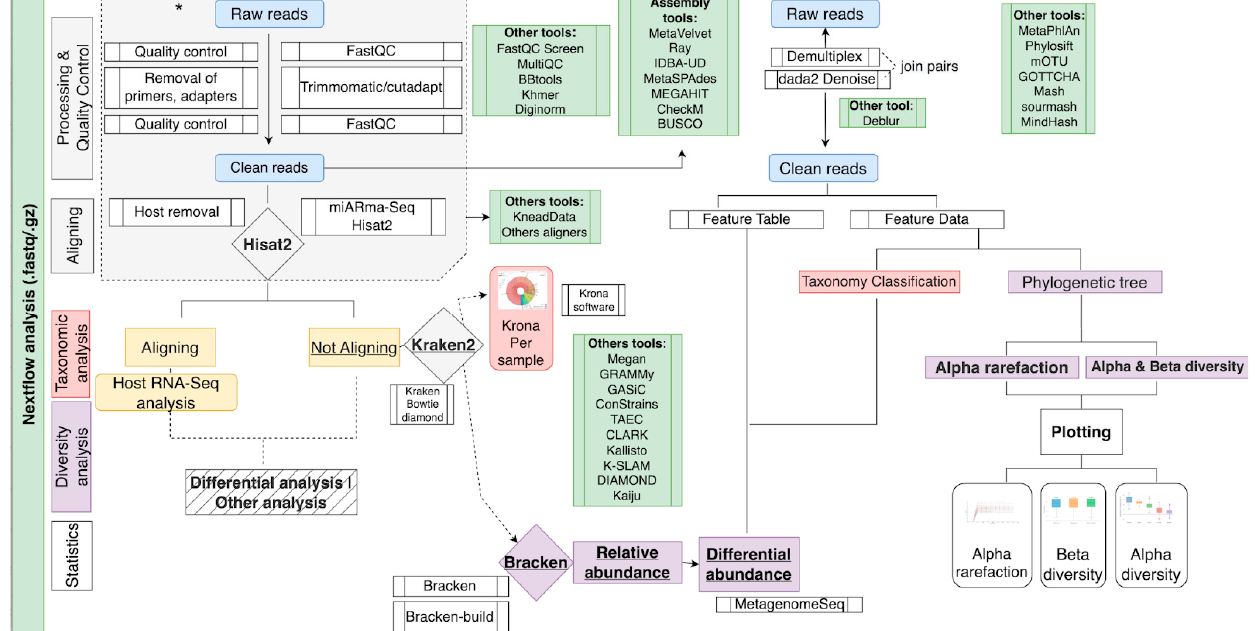
Figure 3 . Overall summary of the Nextflow and QIIME 2 pipeline. The pipeline works in two stages: (1) Pre-processing stage: importing sequences, quality control, different sequences removal, host sequences removal; (2) Nextflow analysis: QIIME2 or Kraken2 relative abundance analysis and differential abundance and statistics analysis using the metagenomeSeq package in R. The main inputs of the Nextflow pipeline are fastq files from RNASeq pre-processing or 16S fastq files. The box marked with ‘*’ is not included in the Nextflow code. Green boxes show other alternative tools not included in these pipelines.